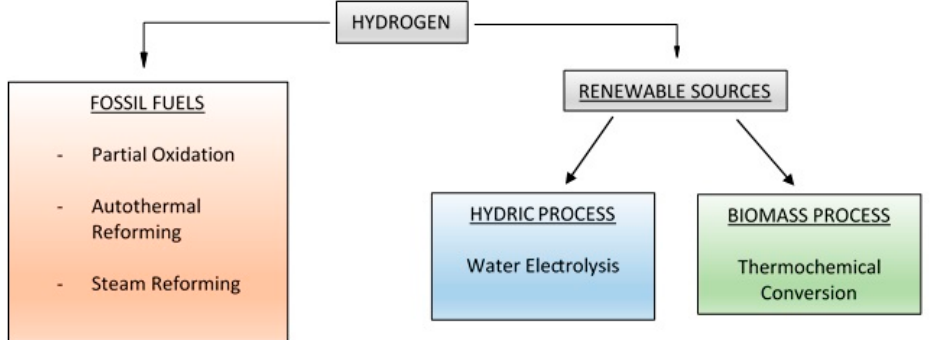
Figure 2. Major hydrogen production technologies .